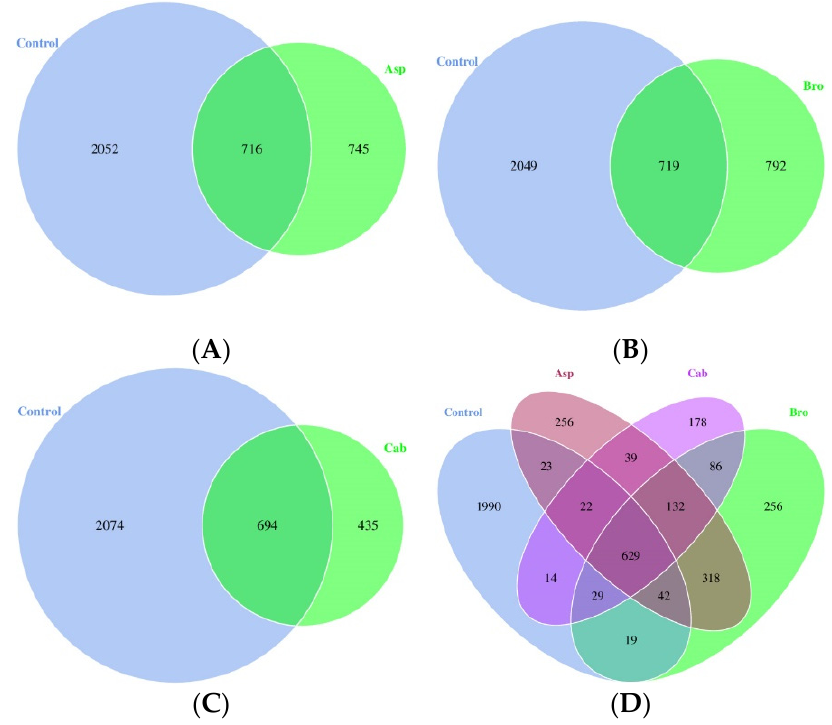
Figure 2. Venn diagram of intestinal flora species in mice. ( A ) Comparison of microflora abundance between control group and cabbage group; ( B ) comparison of microflora abundance between control group and broccoli group; ( C ) comparison of microflora abundance between control group and asparagus group; ( D ) comparison of microflora abundance between four groups.